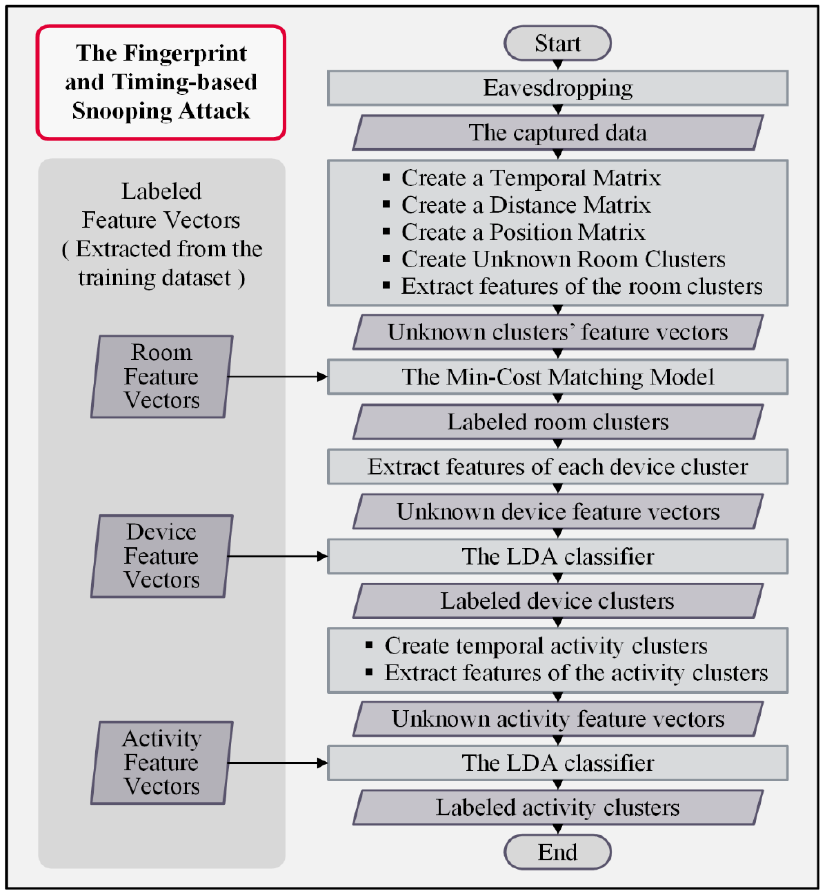
Figure 6. Flowchart of FATS attacks.